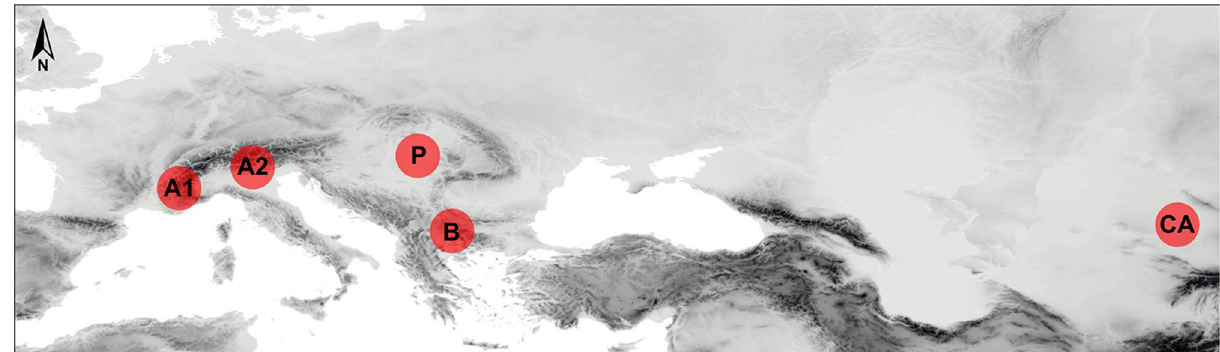
Figure 4. Map of Europe and Central Asia showing the sampling regions; A1 = Western Alps, A2 = Eastern Alps, B = southeastern Balkan Peninsula, CA = Central Asia, P = Pannonia. The underlying map is based on the GTOPO30 Global Digital Elevation Model (available at the United States Geological Service EROS Data Center, https ://doi.org/10.5066/F7DF6 PQS) and has been modified using QGIS version 3.10.5 (https